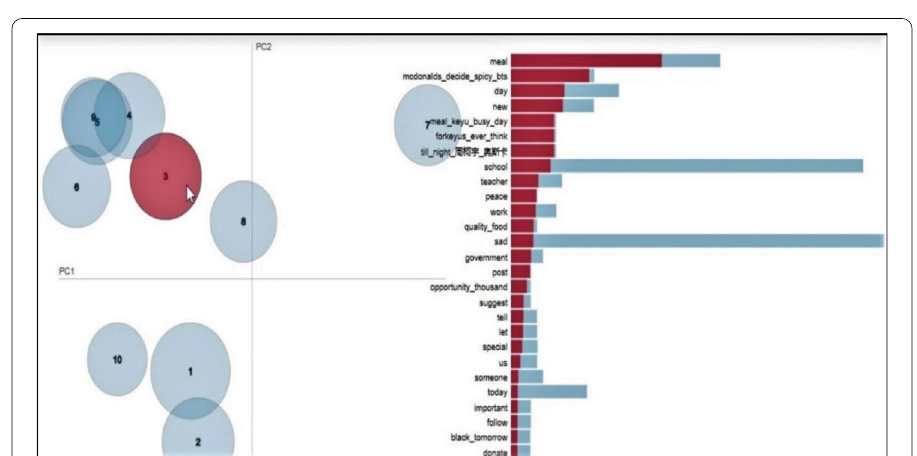
Fig. 13 Topic 3’s most frequent words (marked in red)